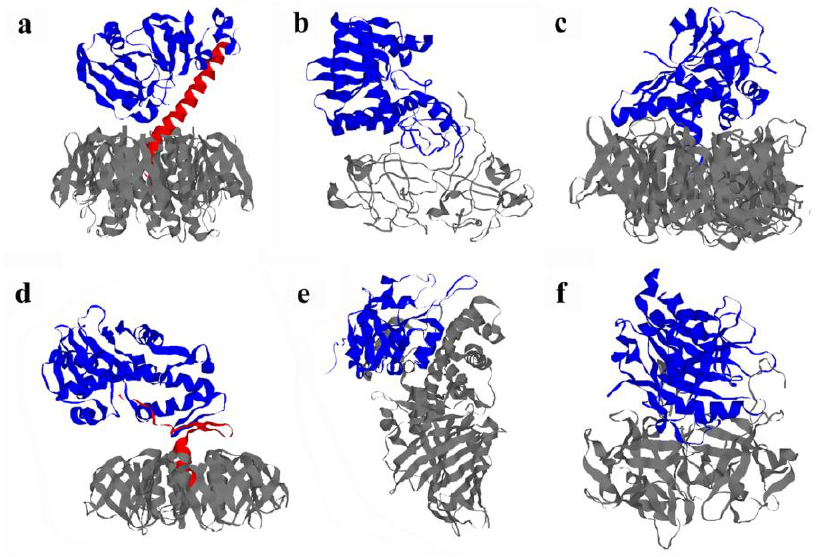
Figure 2. Structural organization of AB-type, ER-translocating toxins. ( a ) Ribbon diagram of cholera toxin (Ctx; PDB 1S5F, [33]). The A1 subunit is in blue; the A2 linker is red; and the B homopentamer is grey. The CtxB pentamer recognizes GM1 gangliosides on the host cell surface, while CtxA1 is an ADP-ribosyltransferase that elevates intracellular cAMP levels by activating the stimulatory α subunit of the heterotrimeric G protein; ( b ) Ribbon diagram of ricin toxin (Rtx; PDB 2AAI, [34]). RtxA is in blue, and RtxB is in grey. RtxB binds to a wide range of glycoproteins and glycolipids with terminal galactose residues, while RtxA is an N -glycosidase that inhibits protein synthesis by removing a specific adenine residue from the 28S rRNA; ( c ) Ribbon diagram of pertussis toxin (Ptx; PDB 1PRT, [35]). The catalytic S1 subunit is in blue, and the five subunits of the B pentamer (S2, S3, two copies of S4, and S5) are grey. PtxB can bind to a variety of glycoconjugates, while PtxS1 is an ADP-ribosyltransferase that elevates intracellular cAMP levels by locking the inhibitory α subunit of the heterotrimeric G protein in an inactive state; ( d ) Ribbon diagram of Shiga toxin (Stx; PDB 1DM0, [36]). The A1 subunit is in blue; the A2 linker is in red; and the B homopentamer is grey. The StxB pentamer binds to globoside Gb3 on the host cell surface, while StxA1 is an N -glycosidase that inhibits protein synthesis by removing a specific adenine residue from the 28S rRNA. The Stx family includes Stx from Shigella dysenteriae (pictured) and the Shiga-like toxins (Stx1, Stx2, and Stx2 isoforms) from Escherichia coli ; ( e ) Ribbon diagram of Pseudomonas aeruginosa exotoxin A (EtxA; PDB 1IKQ, [37]). The catalytic moiety (domain III) is in blue, and the B moiety (domains I and II) is in grey. The B moiety of EtxA binds to the α-macroglobulin receptor/low density lipoprotein receptor-related protein on the host plasma membrane, while the A moiety of EtxA is an ADP-ribosyltransferase that inhibits protein synthesis through the modification of elongation factor 2; ( f ) Ribbon diagram of cytolethal distending toxin (Cdtx; PDB 1SR4, [38]). The catalytic CdtxB subunit is in blue, while the cell-binding CdtxA and CdtxC subunits are in grey. The cell-binding heterodimer binds to cholesterol and glycoconjugates, while the CdtxB subunit is a type I DNase that induces cell cycle arrest by causing double-stranded DNA